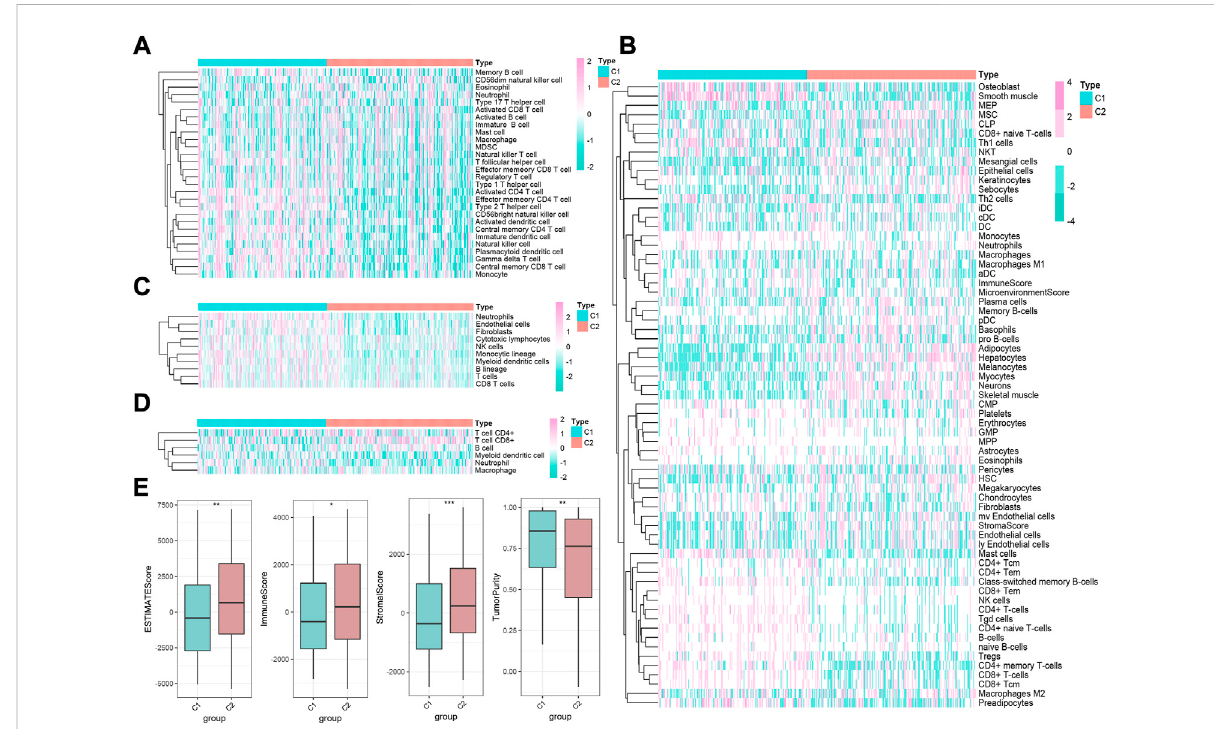
FIGURE 4 Immunelandscapeunderlyingtwodifferentm6Ageneclustersinlivercancer. (A – D) Heatmapsofimmunecellin fi ltrationinm6Ageneclusters based on ssGSEA, xCell, MCP-counter, and TIMER algorithms, respectively. (E) Difference of ESTIMATE, immune, stromal, and tumor purity scores between two m6A gene clusters based on ESTIMATE algorithm (* p < 0.05, ** p < 0.01, *** p < 0.001, **** p < 0.0001, and ns, not signi fi